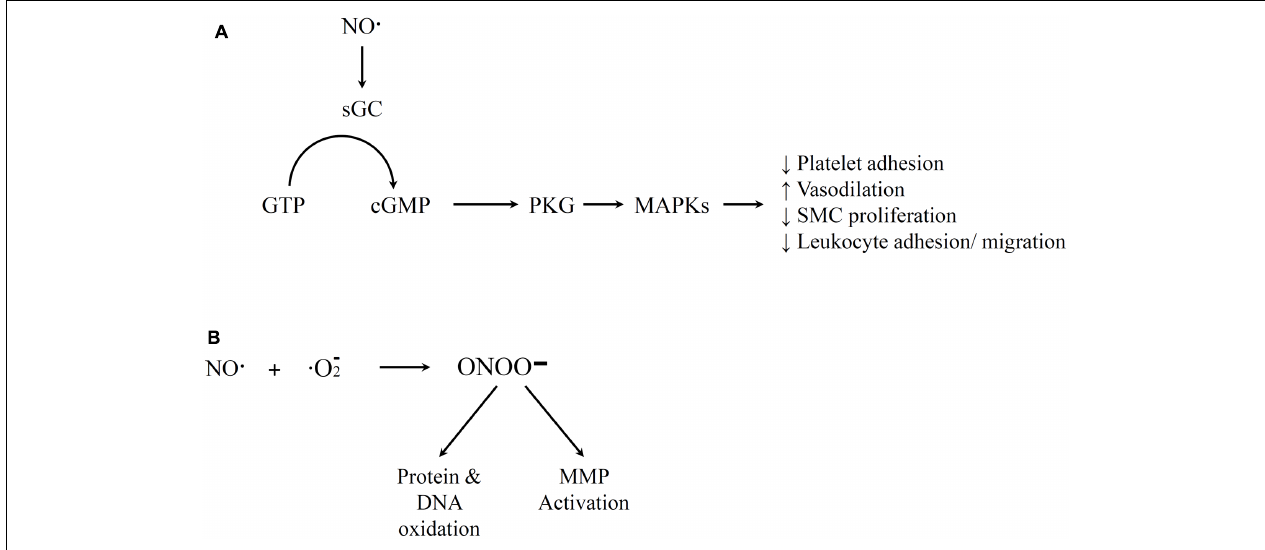
FIGURE 2 | Illustration of nitric oxide (NO) Pathways. (A) Positive medical effects that involve guanylate cyclase activation by NO, conversion of guanosine triphosphate (GTP) to cGMP, and activation of downstream PKG that lead to various vascular homeostasis impacts. (B) Free radical reaction of NO and oxygen that yields peroxynitrite that leads to negative impacts of NO. References for this figure are listed in the